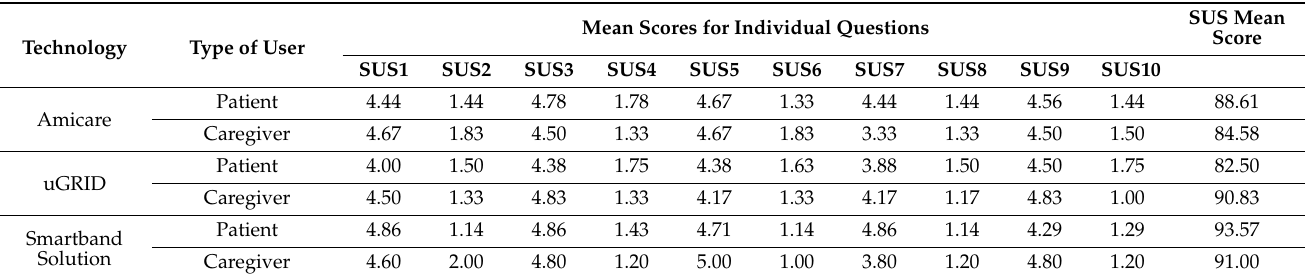
Table 11. SUS mean scores for the individual technologies during the pre-validation phase